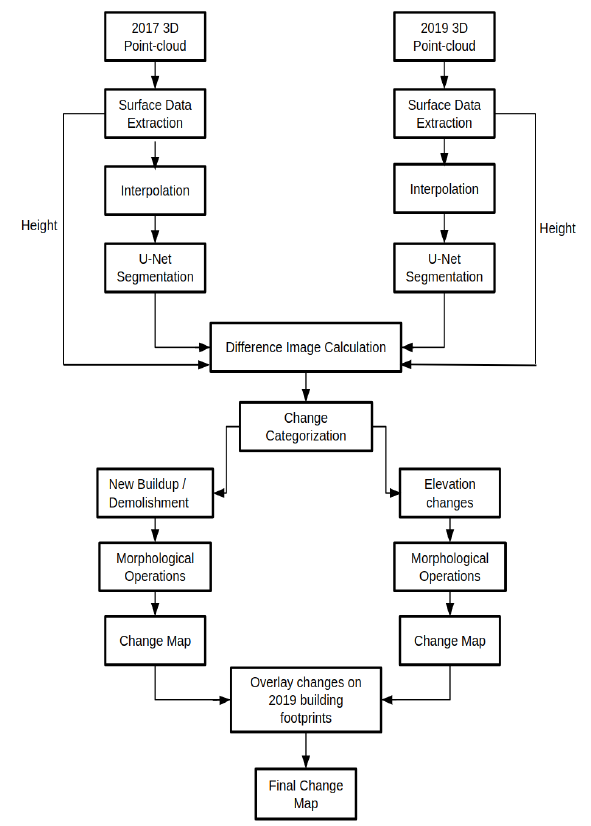
Figure 2. Building Change Detection Workflow.